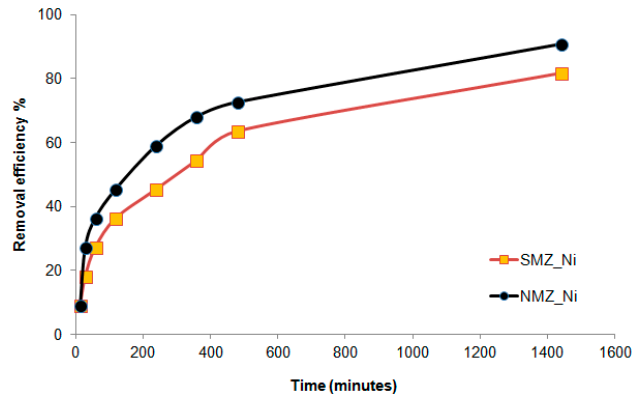
Figure 8. Ni removal efficiency by the surfactant modified and non-modified phillipsite–chabazite tuff as a function of contact time.